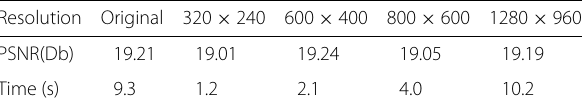
Table 1 Comparison in terms of PSNR over 100 synthetic images with different resolutions